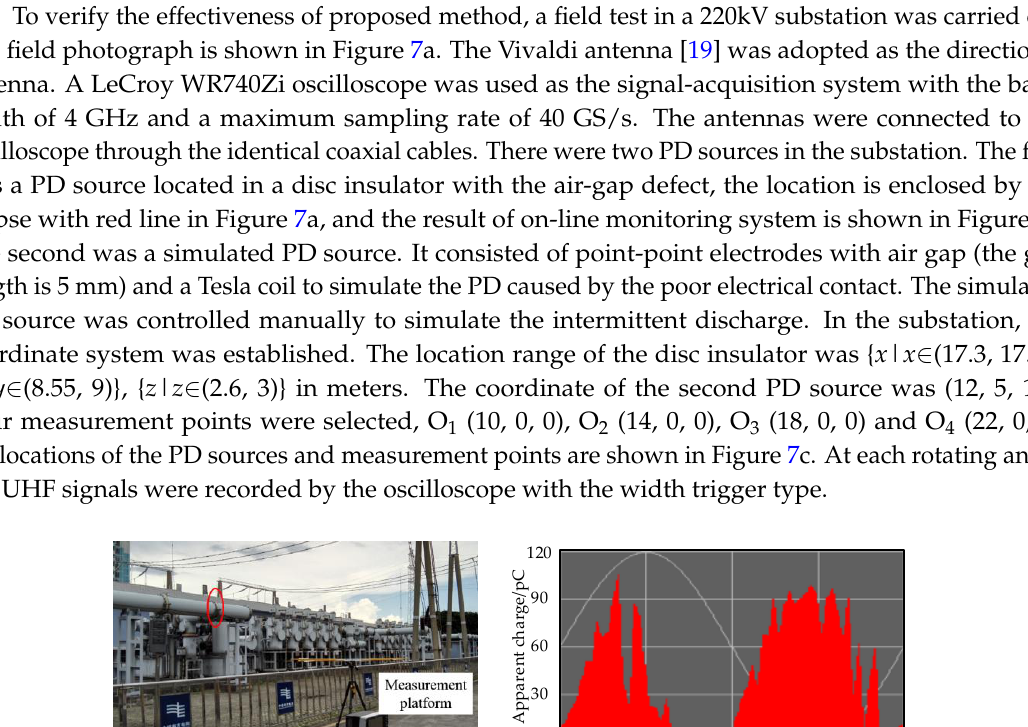
Table 6. The separation results by the proposed method and the published method.